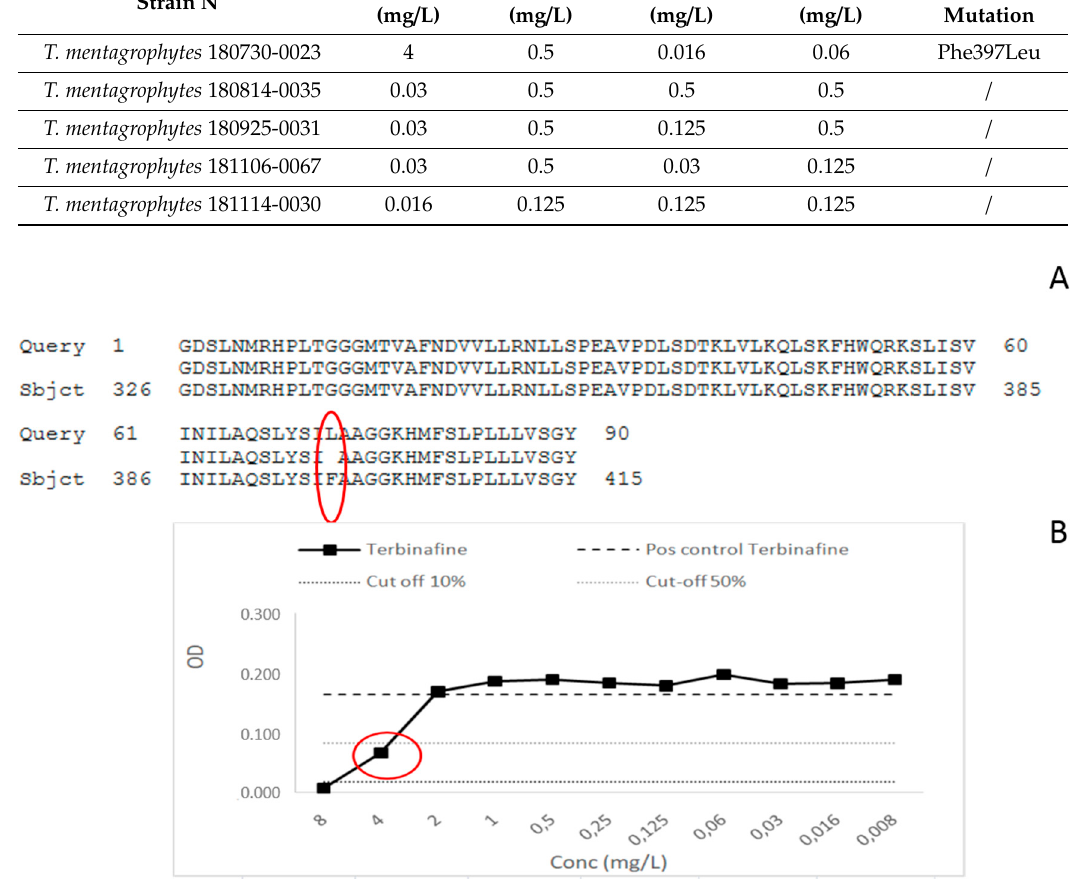
Figure 4. ( A ) Mutation Phe397Leu on the SQLE gene of T. mentagrophytes strain n° 13-180730-0023 surrounded in red. ( B ) MIC determination for terbinafine; the MIC value is surrounded in red and is equal to 4 mg/L.